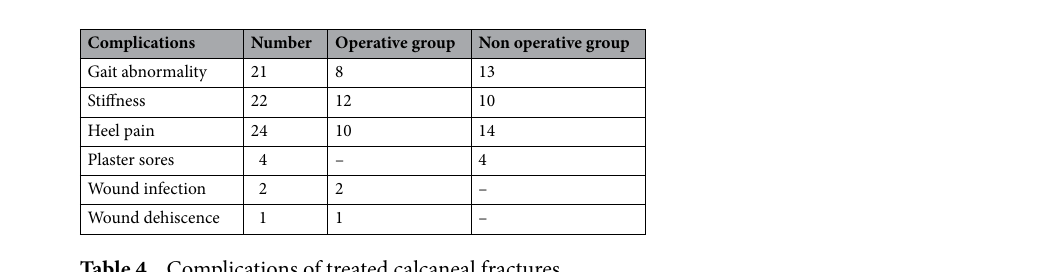
Table 4. Complications of treated calcaneal